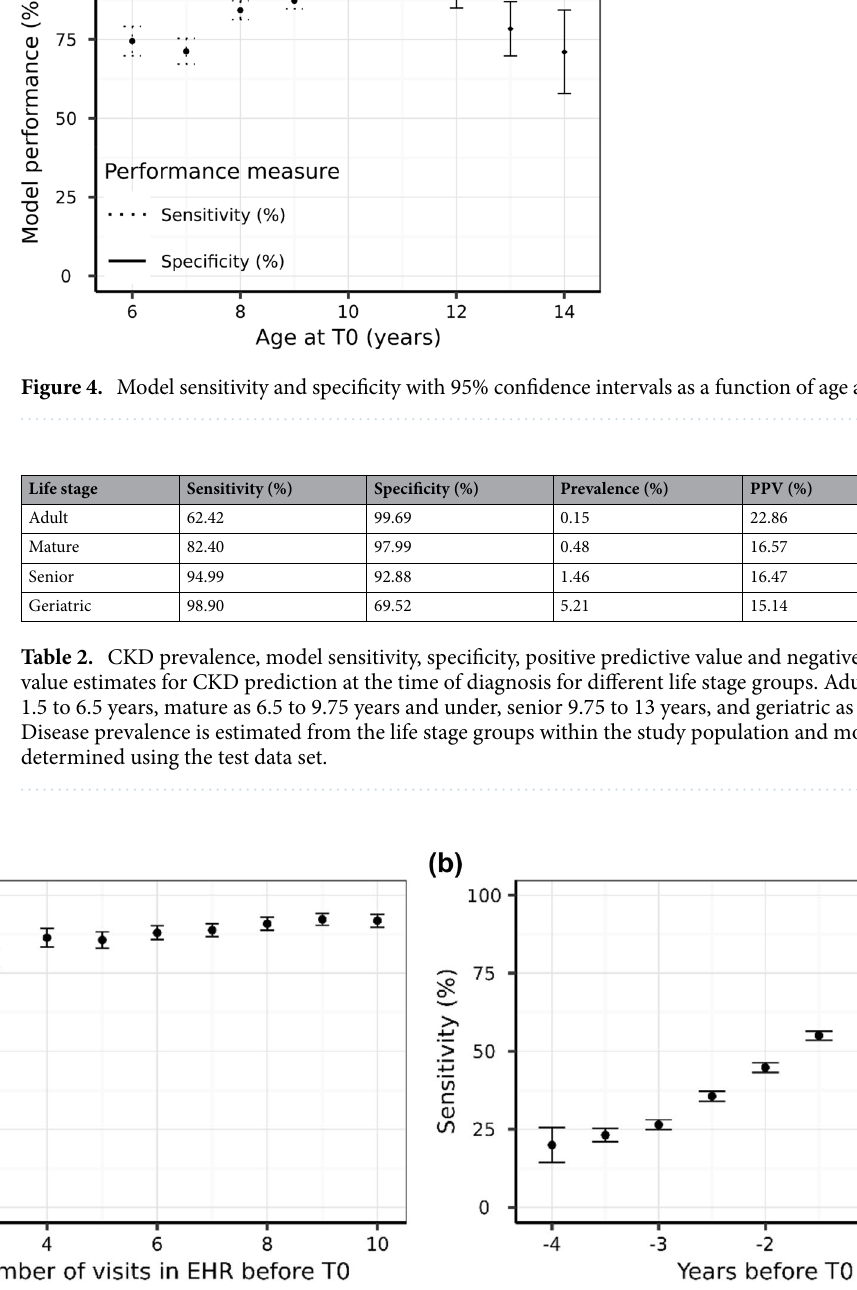
Figure 5. Model sensitivity at T0 with 95% confidence intervals as a function of the number of visits in the EHR before the time of diagnosis T0 ( a ) and model sensitivity with 95% confidence intervals as a function of the time before diagnosis where the prediction was made only with the data up to that point ( b